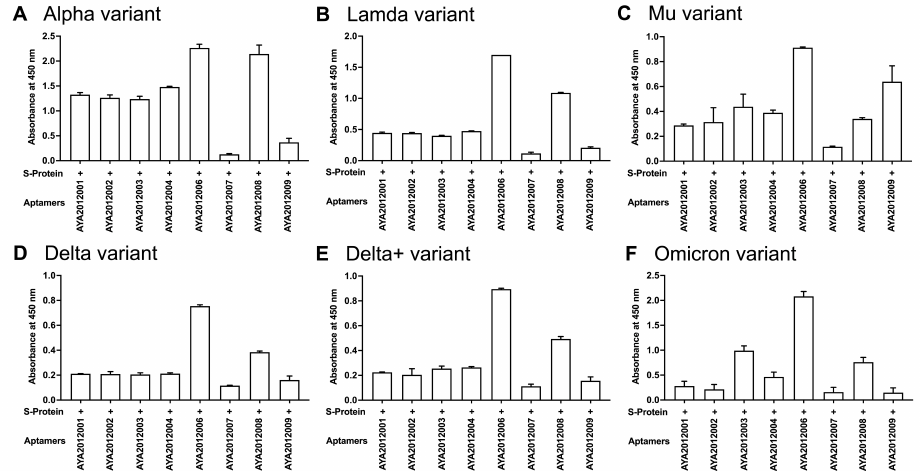
Figure 4. ELISA-based binding assay of selected aptamers to variants of SARS-CoV-2 trimer S protein. Recombinant SARS-CoV-2 trimer S protein from ( A ) Alpha, ( B ) Lambda, ( C ) Mu, ( D ) Delta, ( E ) Delta plus, and ( F ) Omicron variants were immobilized on a MaxiSorp plate. First, 10 nM of biotinylated aptamers were incubated with the indicated variant for 1 h. Bound aptamers were detected using streptavidin–HRP. Each value was the average of duplicate measurements. Error bars represent mean ± SD ( σ